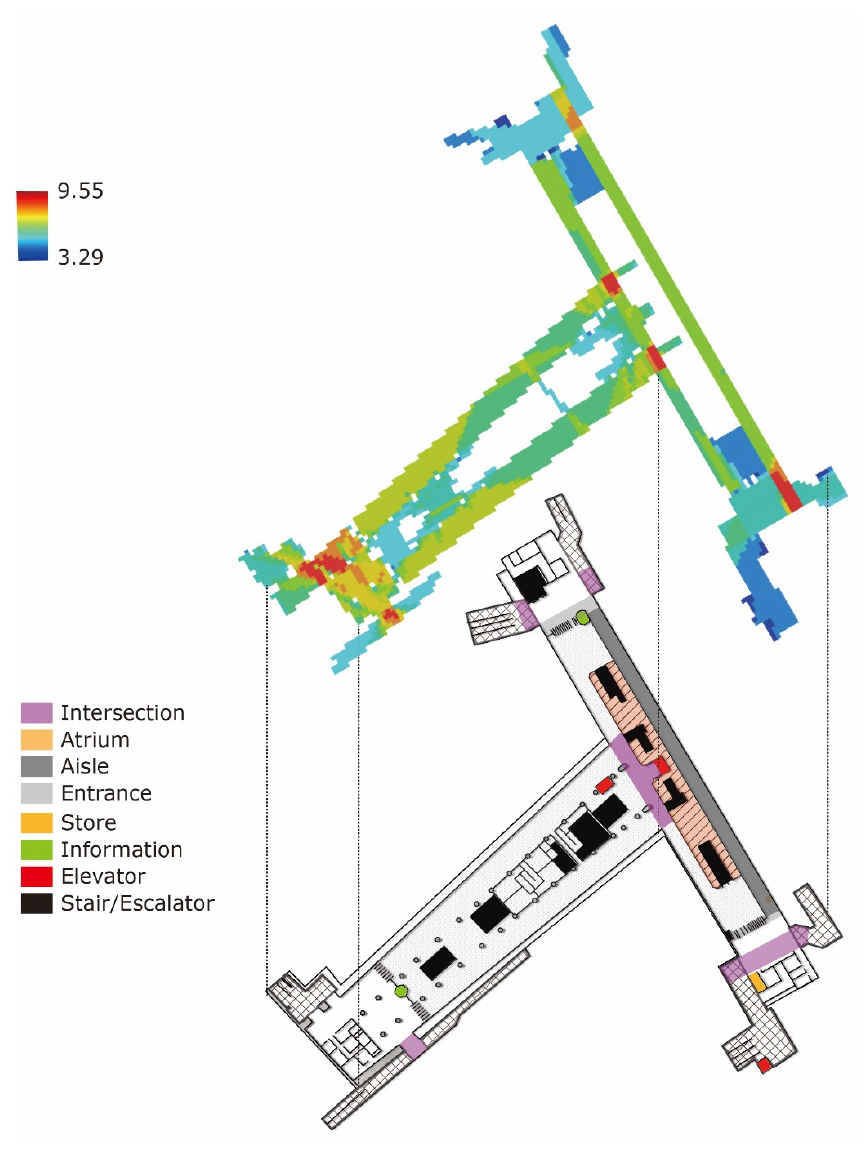
Figure 4. Visibility analysis of the concourse level at Zhongxiao Xinsheng station. Table 2. Quantified comparison of visibility between different spatial divisions of the concourse level at Zhongxiao Xinsheng station.